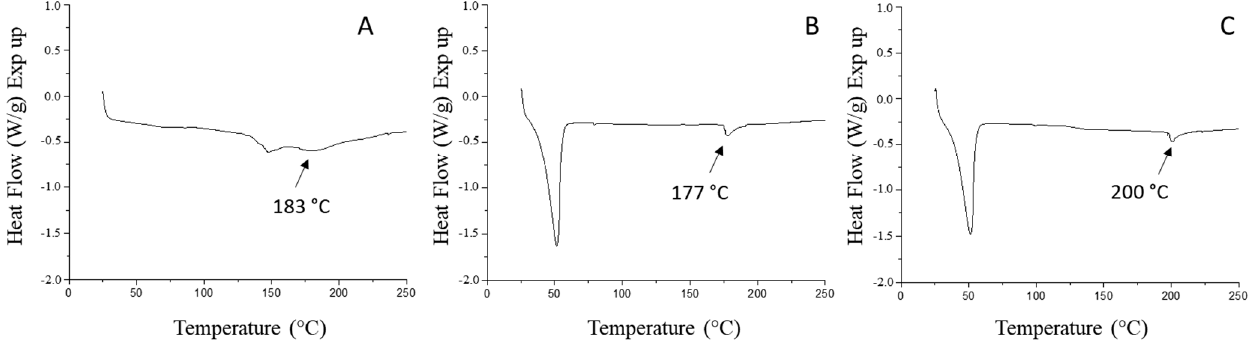
Figure 4. Differential scanning calorimetry (DSC) thermograms of microparticles prepared by ( A ) spray drying (SD), ( B ) spray chilling (SC), and ( C ) Spray drying and chilling combination (SDC). The numerical suffix denotes the core:wall material ratio of the selected formulation.